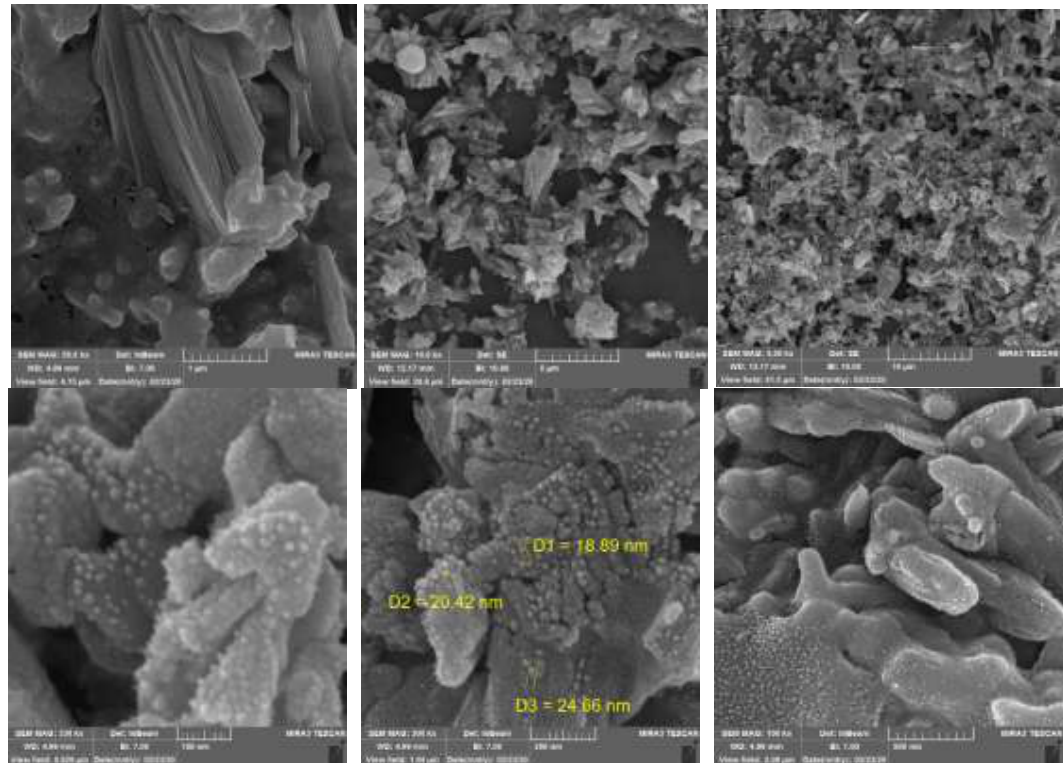
Fig.8: The SEM micrograph for CNTs-Sr(OH)